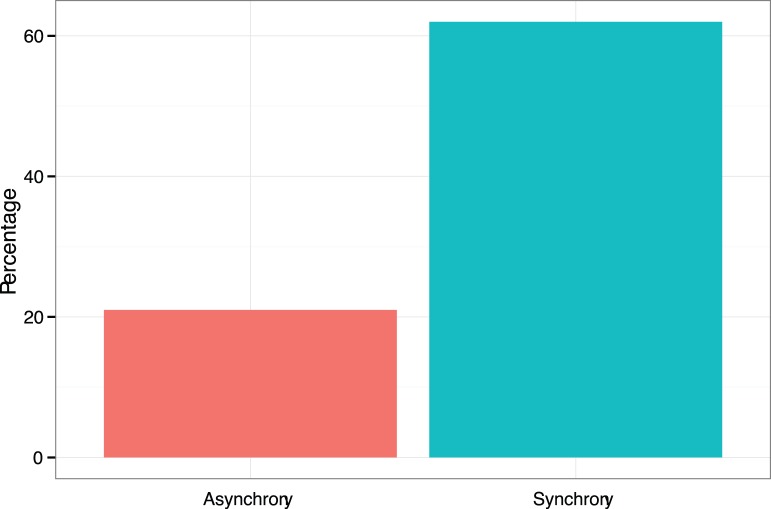
Cooperation across experimental conditions for Experiment 2.The percentage of participants choosing the cooperative Y option for each of the two vocalising conditions.